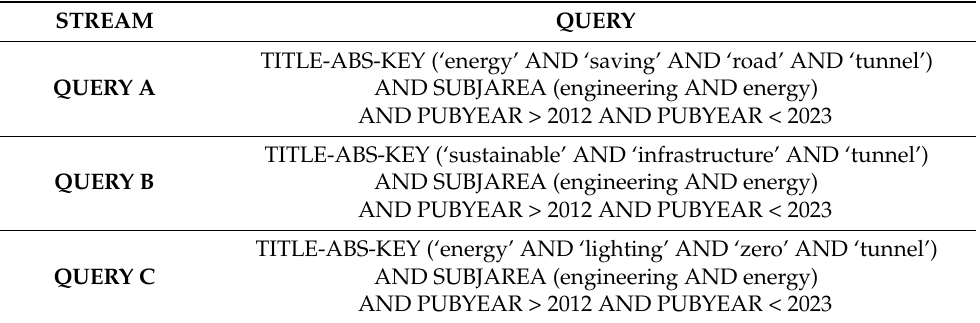
Table 1. Query inputs for research on